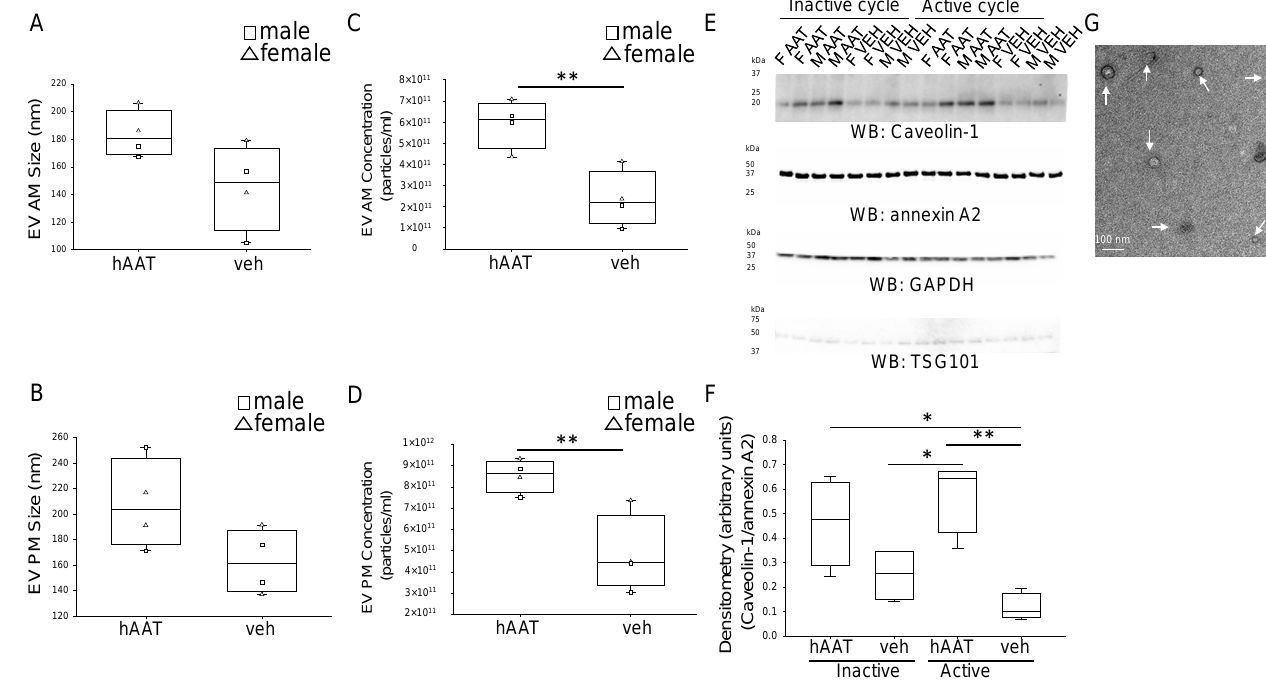
Figure 10. Characterization of urinary EVs from hAAT and vehicle treated db/db mice. ( A ). Summary graph for EV size from the active (AM) cycle. ( B ). Summary graph for EV size from the inactive (PM) cycle. ( C ). Summary graph for EV concentration from the active (AM) cycle. ( D ). Summary graph for EV concentration from the inactive (PM) cycle. ( E ). Western blots for multiple EV markers including caveolin-1, annexin A2, GAPDH, and TSG101. ( F ). Densitometric analysis of the caveolin-1 blot normalized to the Annexin A2 blot. ( G ). Representative TEM image of uEVs from diabetic db/db mice. AM reflects urine collected overnight during the active cycle of the mice and PM reflects urine collected during the day of the inactive cycle of the mice. White arrows indicate individual uEVs. * p < 0.05 and ** p <